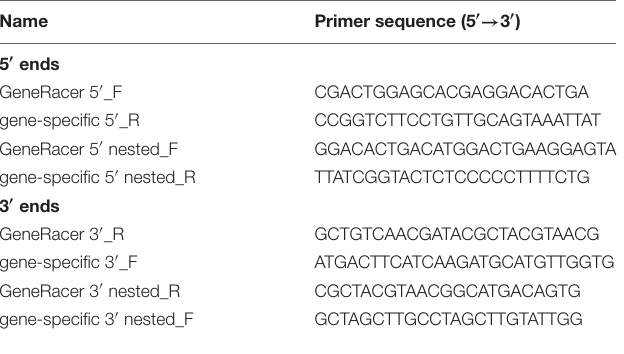
TABLE 1 | Primer set used for